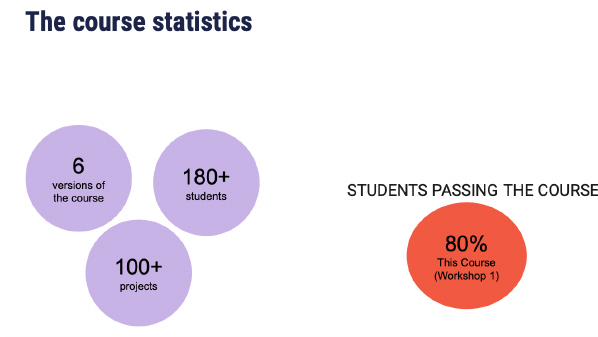
Figure 4. Key stats of the course